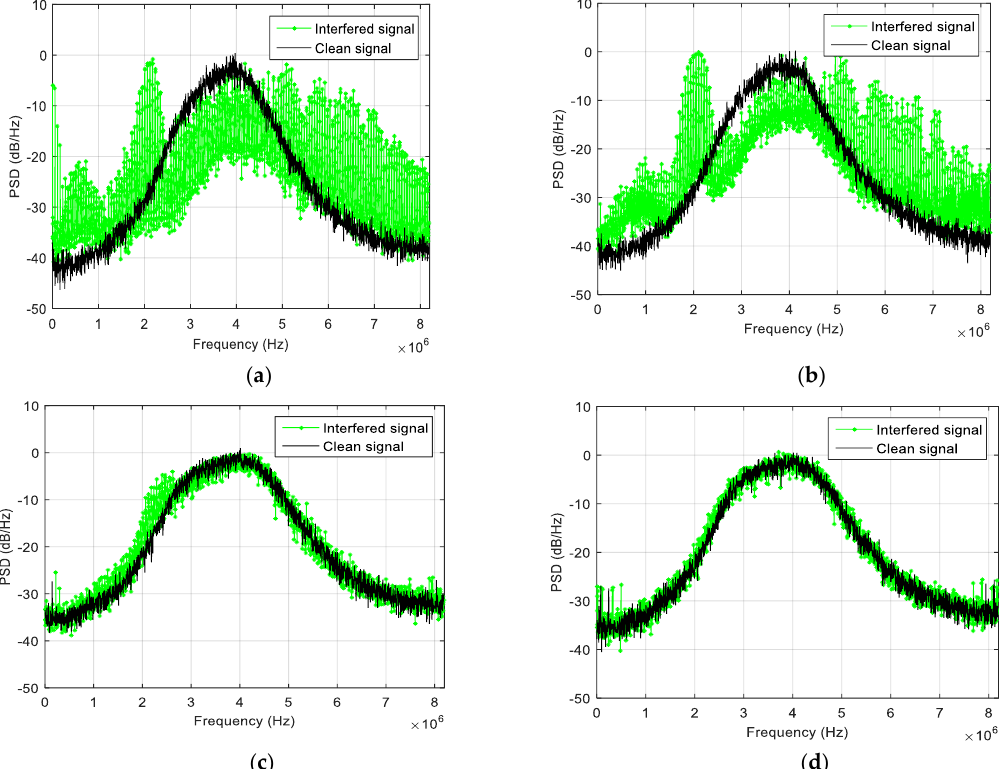
Figure 5. Effect of the wideband jammer on the received PSD for different power levels: − 60 dBm ( a ),